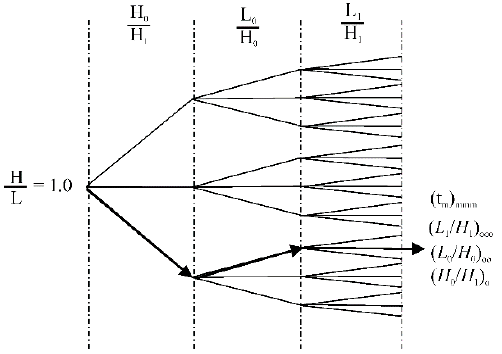
Figure 3. Flowchart of the performed simulations in geometric evaluation of the T-shaped empty channel in resin infusion simulation.